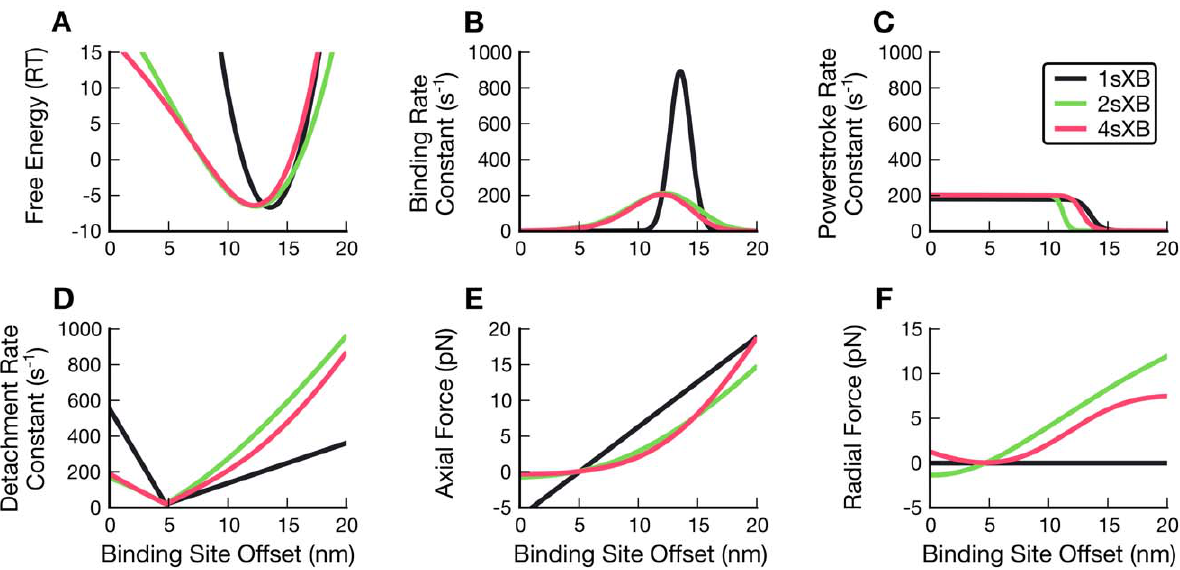
Figure 2. Forces, energy, and kinetics of the 1sXB, 2sXB, and 4sXB models at resting lattice spacing. (A)–(F) show the energy, transition rate constants, and forces of the 1sXB model (black), 2sXB model (green), and 4sXB model (red) at resting lattice spacing. The 1sXB model values shown for comparison are derived from those of Daniel et al. (1998) and Tanner et al. (2007), [12,14], shifted axially so the resting location of the cross- bridge head in each case is aligned with the resting locations of the 2sXB model and 4sXB model allowing easier comparison. The free energy of the cross-bridges in state two is shown in (A), where the multi-spring cross-bridges’ shifts from a purely parabolic trajectory is visible. The explicit two- dimensional thermal forcing of the multi-spring cross-bridge heads in (B) results in binding probabilities that are more distributed than those of the single spring cross-bridge. The rate of power strokes (C) remains least changed between the single and the multi-spring cross-bridge models. The energy-based kinetics of the multi-spring cross-bridges are unable to fully replicate the biased detachment rate of the 1sXB model in (D). (E) and (F) show the 1sXB’s sharp discontinuities in axial force and lack of any radial force. 4sXB models (Figure 2D). The rate of detachment and the other cross-bridge kinetic rate constants remain close to those of the 1sXB, even though the kinetics of the multi-spring cross-bridges are based not on axial position but on the free energy of the cross- bridge in multiple dimensions.